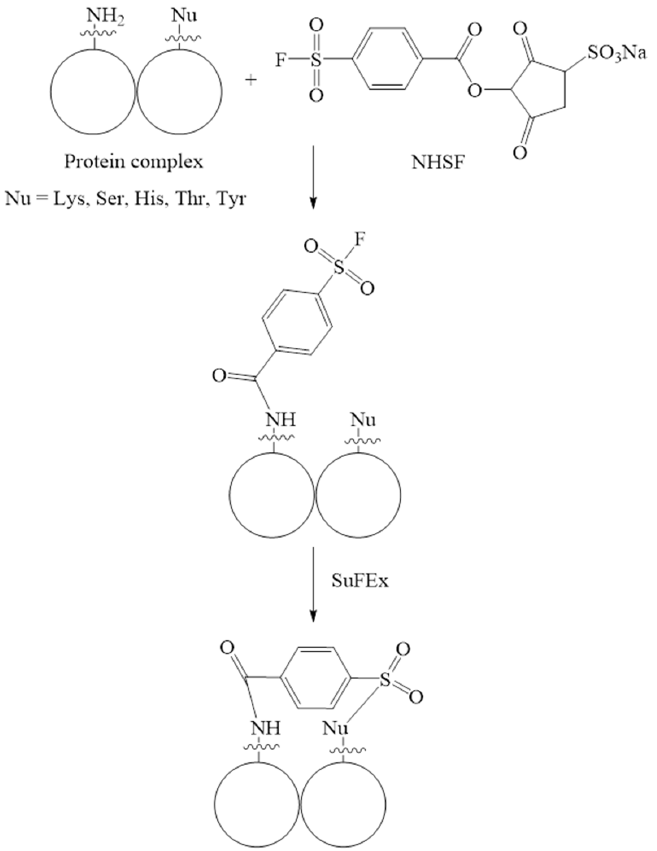
Figure 9. The reaction of N ‐ hydroxysulfosuccinimide and aryl sulfonyl fluoride (NHSF), a multitar